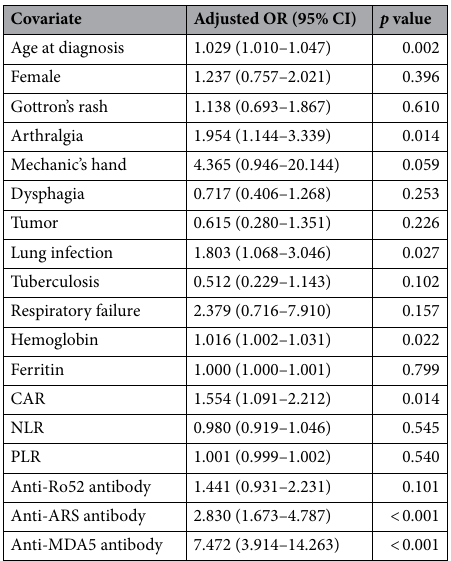
Table 2. Risk factors of ILD in patients with idiopathic inflammatory myopathies. CAR, the C-reactive protein to Albumin ratio; NLR, Neutrophil-to-lymphocyte ratio; PLR, platelet-lymphocyte ratio; ARS, aminoacyl-tRNA